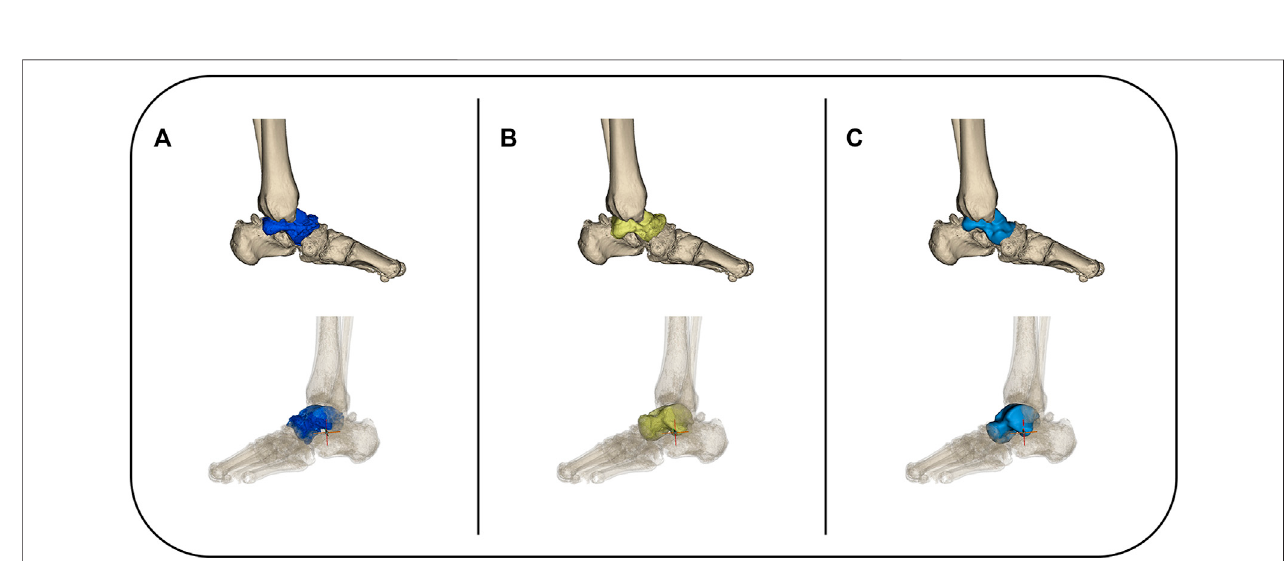
FIGURE3| Theaffectedtalarwasthree-dimensionallyreconstructed (A) andreplacedusingamirroroftheunaffectedside insitu (B) .Thereconstructed3Dmodel was then smoothed and wrapped until the overall and local details were satisfactory (C) .